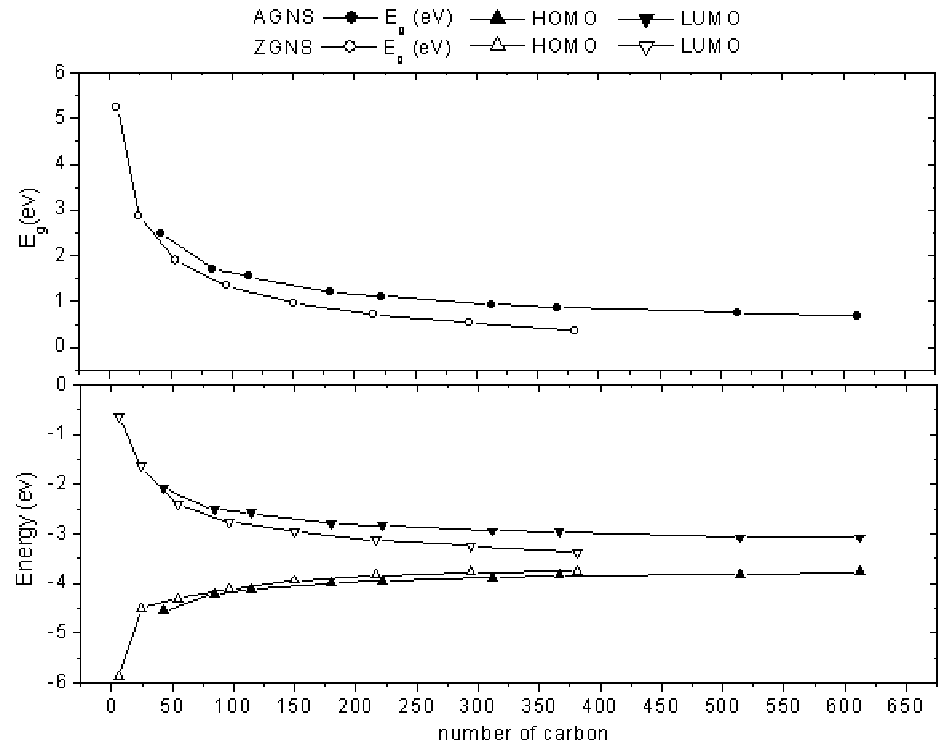
Figure 2. Calculated E both for armchair and zigzag